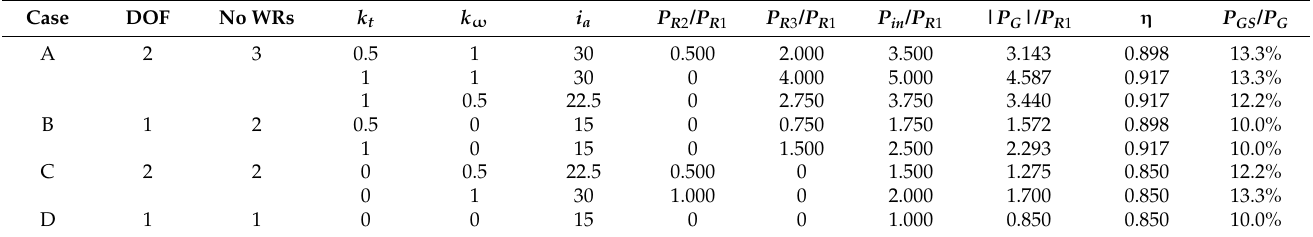
Figure 9. Reduced power flows of the 2-DOF and L = 4 system (Case C) for k ω = 0.5 (blue) and ω 1 (red). Table 5. Performances of the four WSCGs for certain representative numerical scenarios.